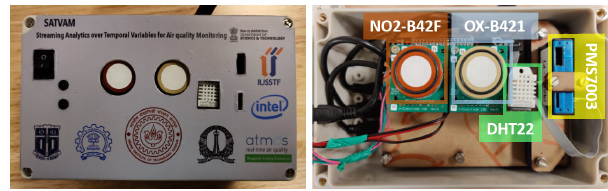
Figure 3. Primary components of the SATVAM LCAQ (low-cost air-quality) sensor used in our experiments. The SATVAM device consists of a Plantower PMS7003 PM 2 . 5 sensor, Alphasense OX- B431 and NO2-B43F electrochemical sensors, and a DHT22 RH and temperature sensor. Additional components (not shown here) include instrumentation to enable data collection and transmission.